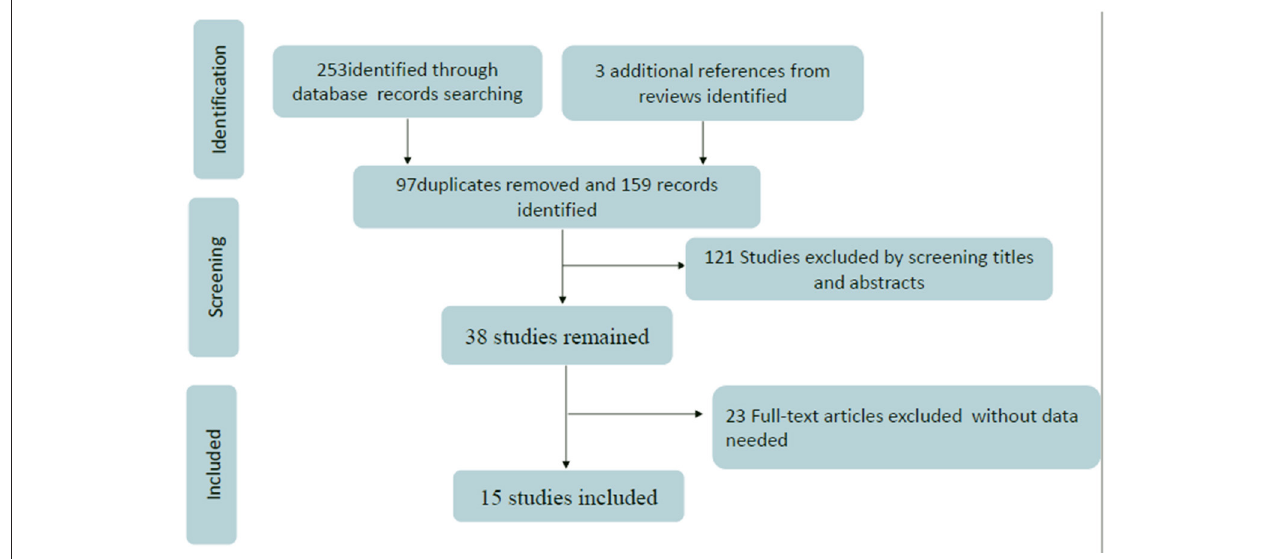
FIGURE 1 | Flowchart presenting the steps of the literature search and selection.